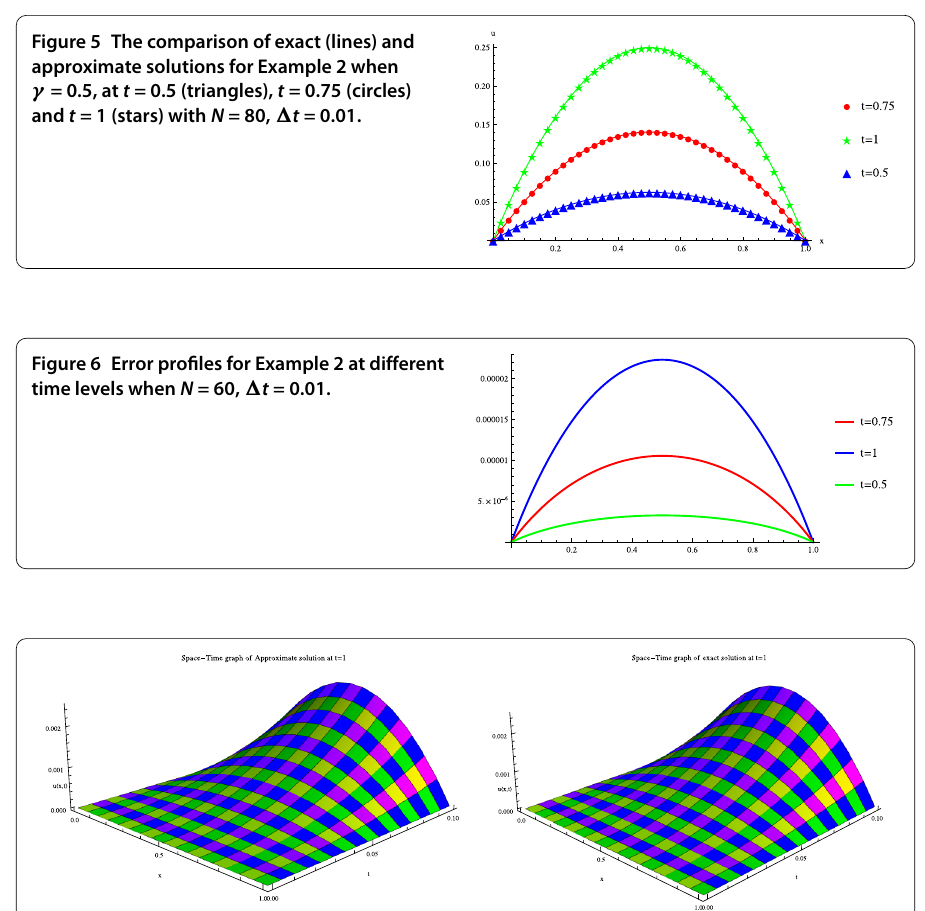
Figure 7 3D space-time graphs of exact (right) and numerical solutions (left) for Example 2.